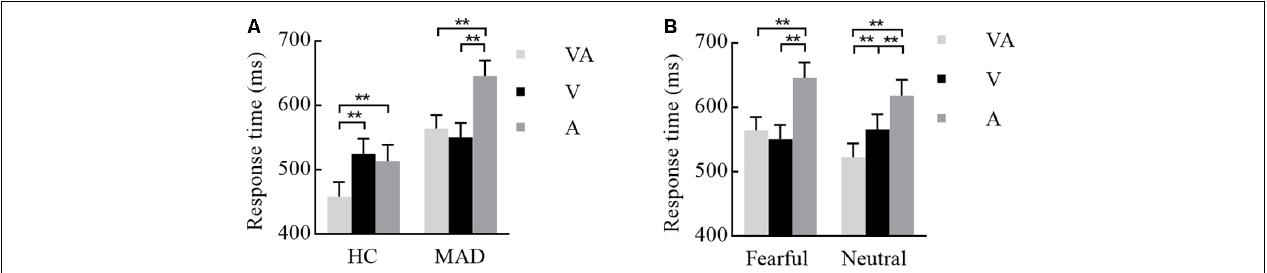
FIGURE 2 | Combination of the results of Experiment 1. (A) Under a fearful emotion, a significant modality effect was noted in HCs and MADs. Results show a shorter RT for VA than A and V in HCs; however, there was no significant difference between VA and V in MADs. Besides, MADs had a longer RT than HCs in VA and A, not in V. (B) Under a neutral emotion, a significant modality effect was seen in MADs as a shorter RT for VA than A and V. ** p <